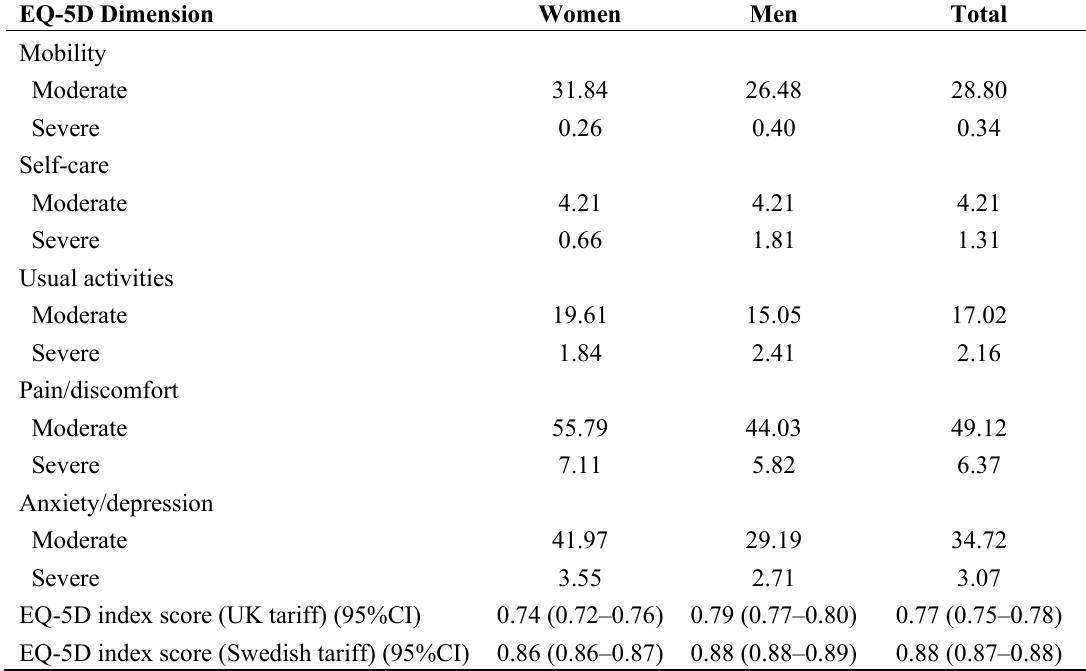
Table 2. Percentage of respondents with moderate/severe problems in EQ-5D dimensions and EQ-5D